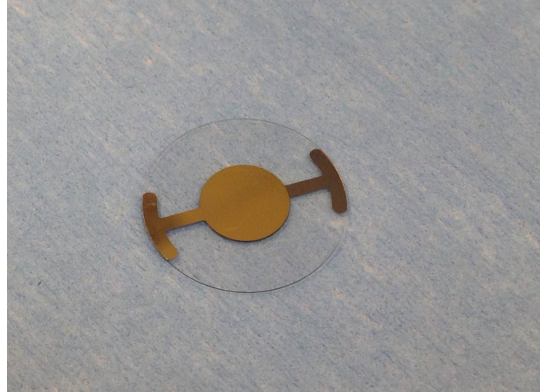
Figure 1. Piezoelectric crystal microbalance: quartz crystal (trans- parent plate) and gold electrode in the centre. On the right side and left side are the contact points for the proximity